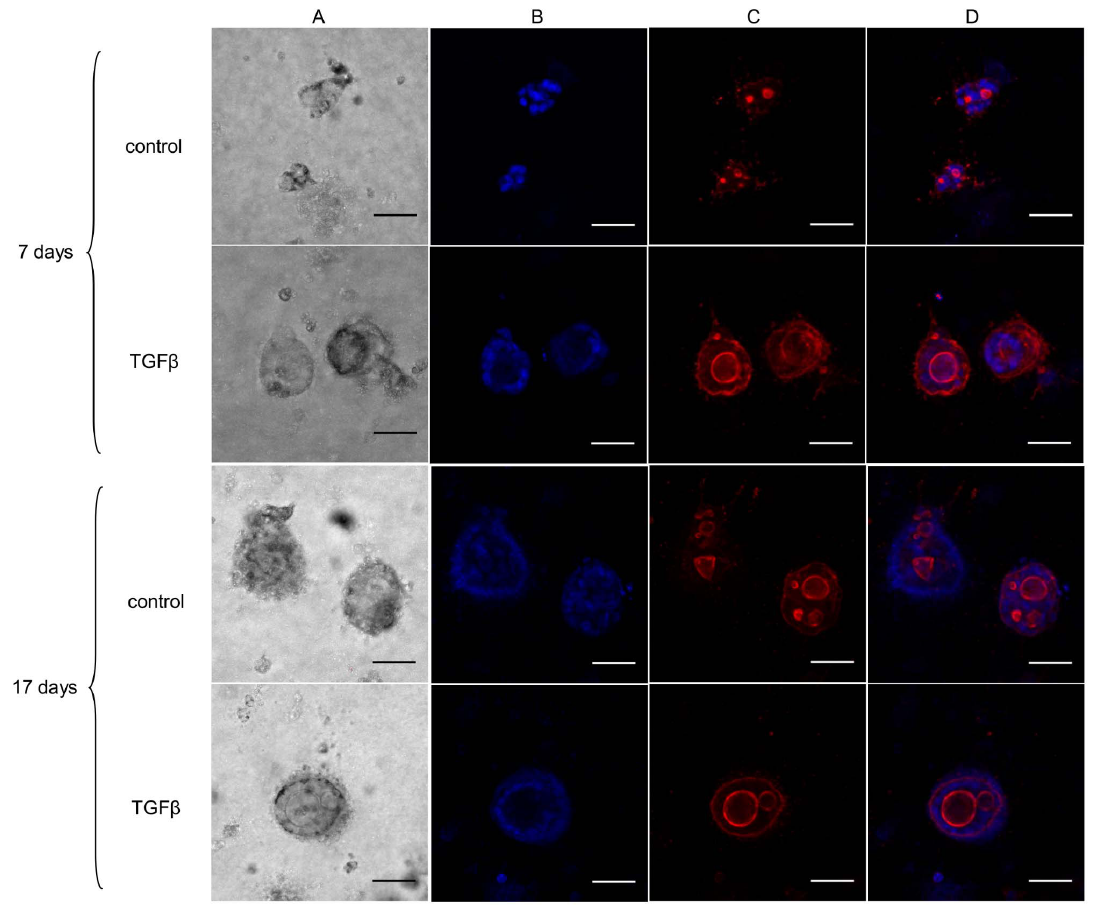
Figure 1. Effect of TGF- b on T84 3D epithelial cell organization. Confocal microscopy of 7 and 17 day-old T84 in three-dimensional culture. All images are at 20 6 magnification. Scale bar represent 50 m m. A) T84 colonies are observed with phase contrast. B) Cell nuclei stained with Hoechst. C) Filamentous actin is stained with Phalloidin-PE. In D, merged images of B and C.